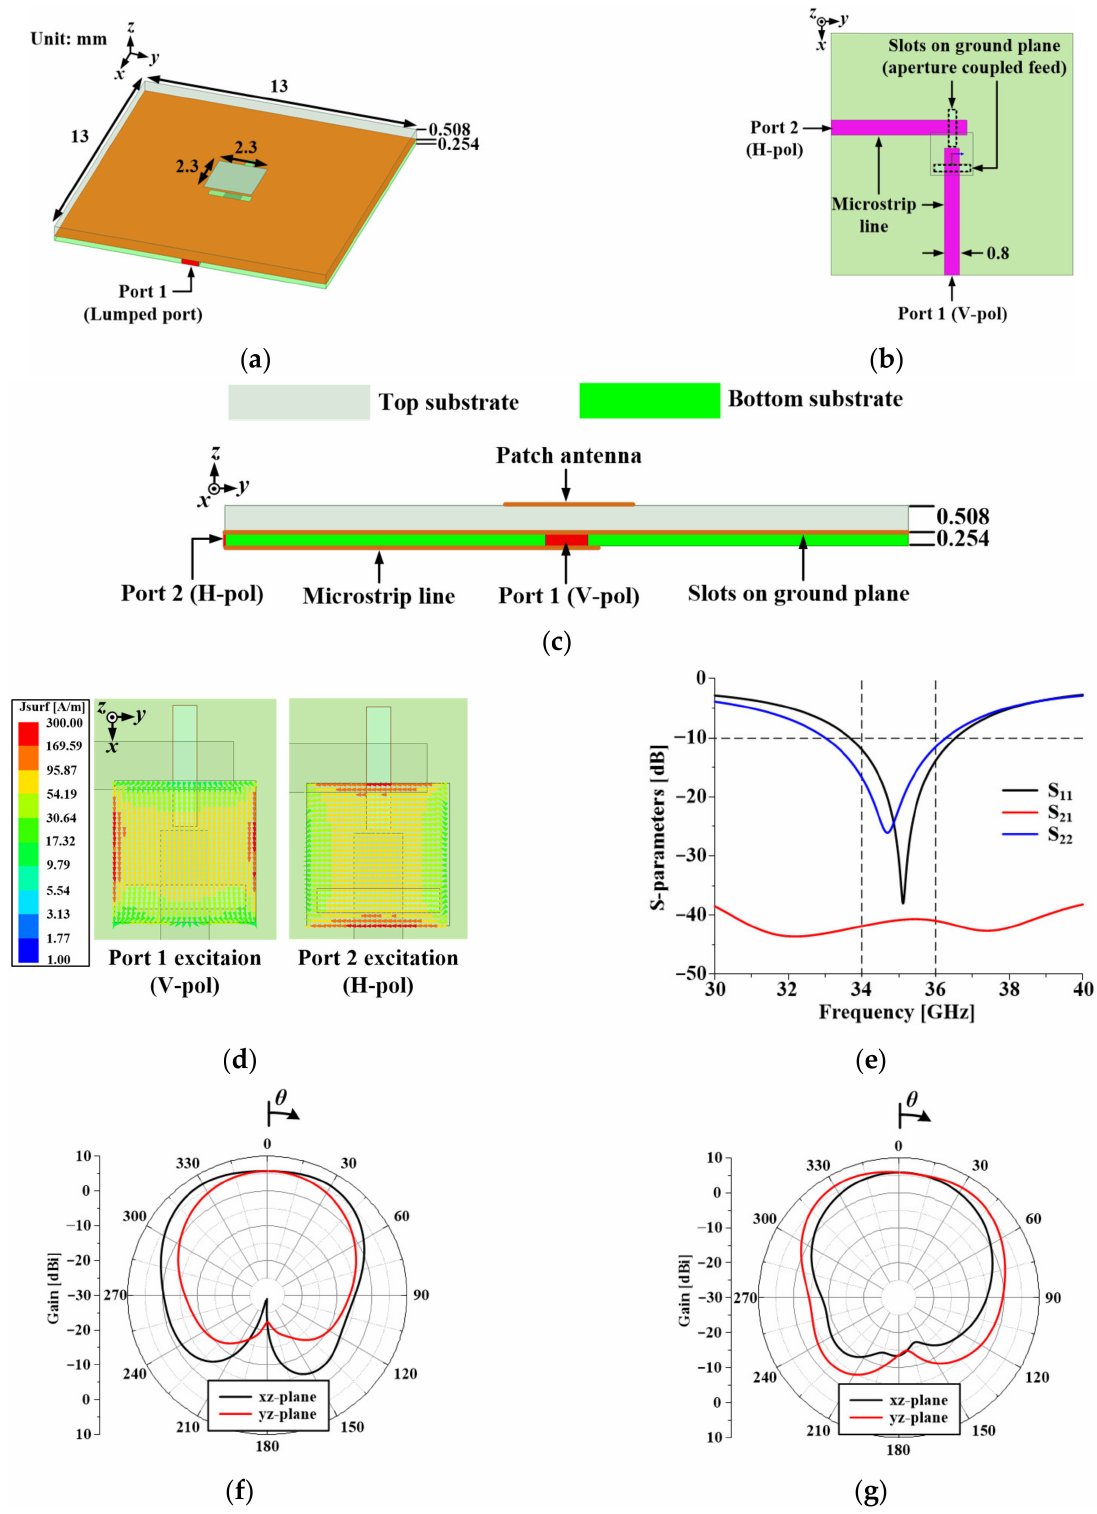
Figure 1. Single patch antenna: ( a ) geometry of antenna, ( b ) perspective view, ( c ) side view, ( d ) simulated surface current distribution at 35 GHz, ( e ) simulated S-parameters, ( f ) simulated radiation patterns at 35 GHz when Port 1 is excited, and ( g ) simulated radiation patterns at 35 GHz when Port 2 is